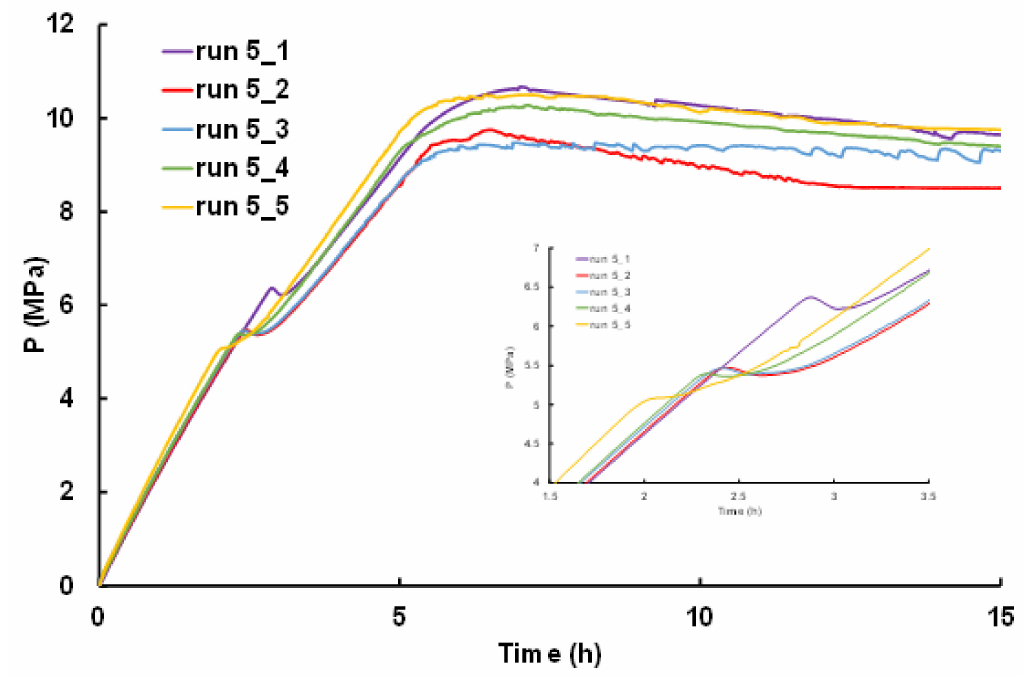
Figure 6. Pressure-time profile during hydrate formation experiments at constant operating